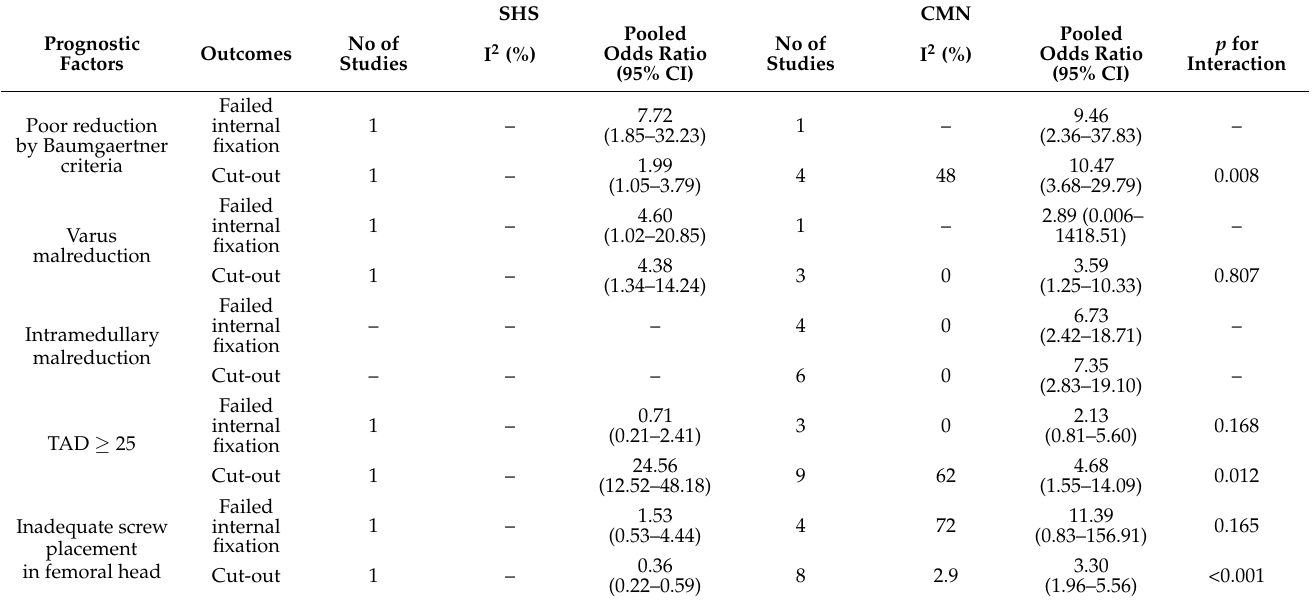
Table 2. Subgroup analysis on the association between immediate postoperative radiographic findings and failed internal fixations by implant type.